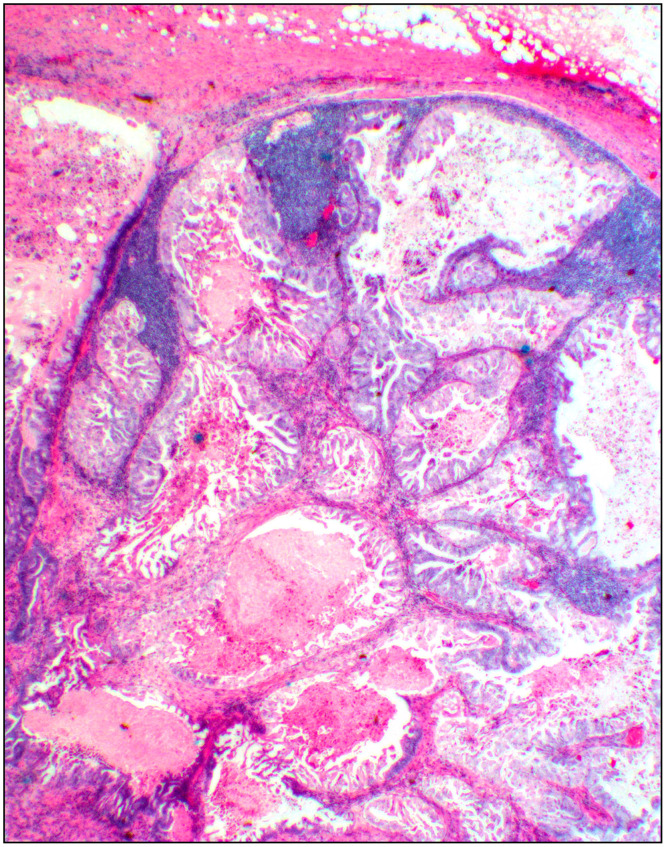
Metastasis.A sentinel lymph node with a metastatic carcinoma (case # 54, S1 and S5 Tables). Hematoxylin and eosin stain shows almost complete effacement of the lymph node by endometrioid adenocarcinoma. Small clusters of remnant lymphoid cells are present (2x objective).